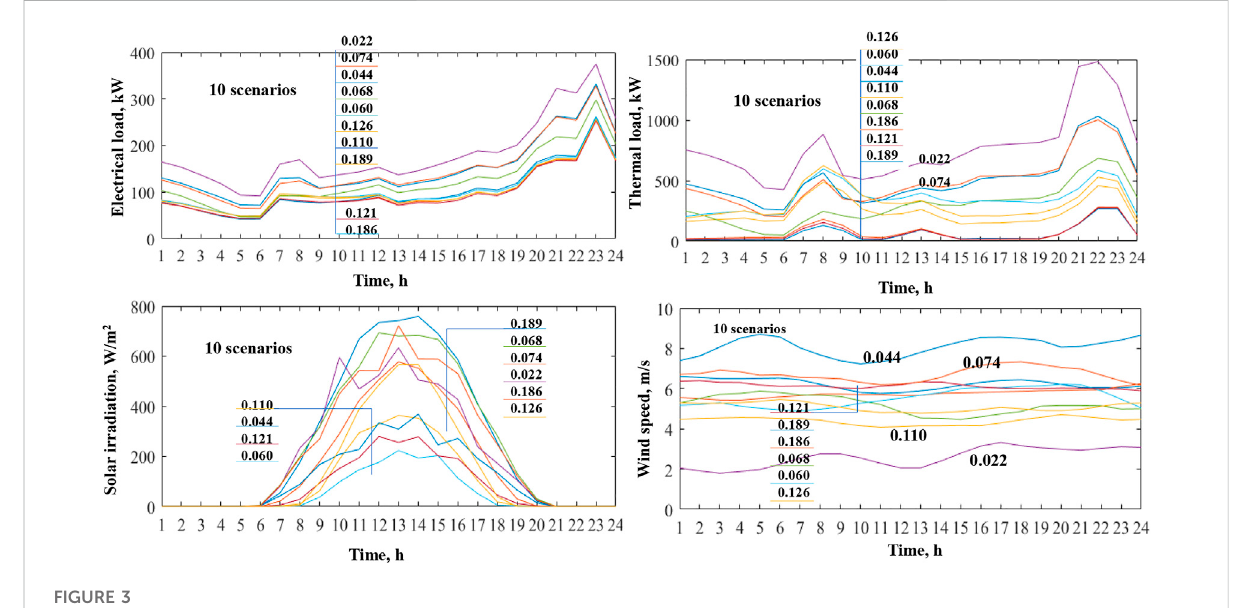
FIGURE 3 Generated scenarios of loads and weather